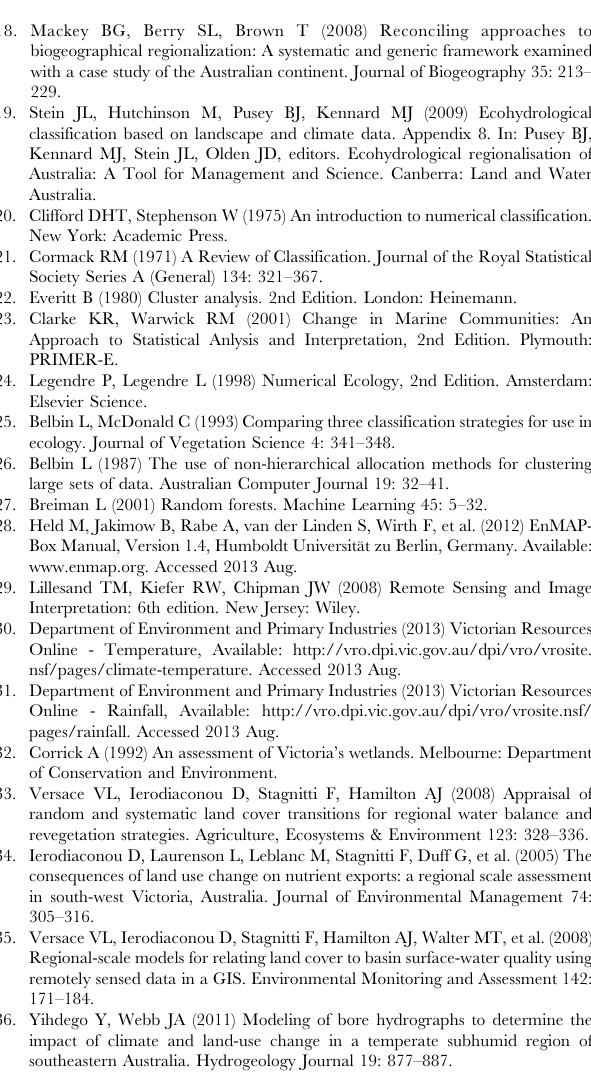
Table S2 SIMPER results from PRIMER 6. Numbers represent % contribution of each of the variables to the ALOC 23 and ALOC 20 meta-groups on a standardised Euclidean distance matrix. Blank columns are meta-groups that only contained 1 ALOC cluster and therefore % contribution could not be calculated using SIMPER. KW = Kruskal-Wallis statistic, with higher values indicating a better ability of that variable to discriminate between clusters. All KW values were significant at p ,, 0.001. See Figure S9 for a graphical representation of this table. Table S3 Total accuracies and kappa statistics for the 4 RF classified models, and producer and user accuracies for each of the classes defined by the ALOC algorithm as classified by RF. N/A indicates groups that were missing from the classified dataset as a result of exclusion from the samples used to train the RF model. In some cases, groups were absent from the